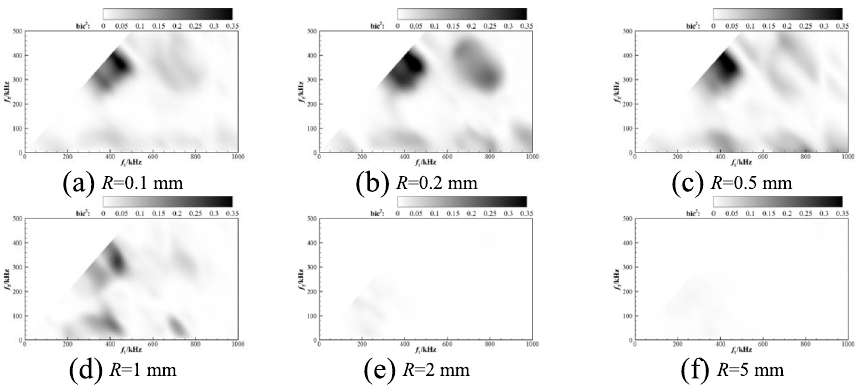
Fig. 14 Bicoherence contour of instability wave interactions measured by the PCB sensor NO.1 at Re unit 10E 6/m = +